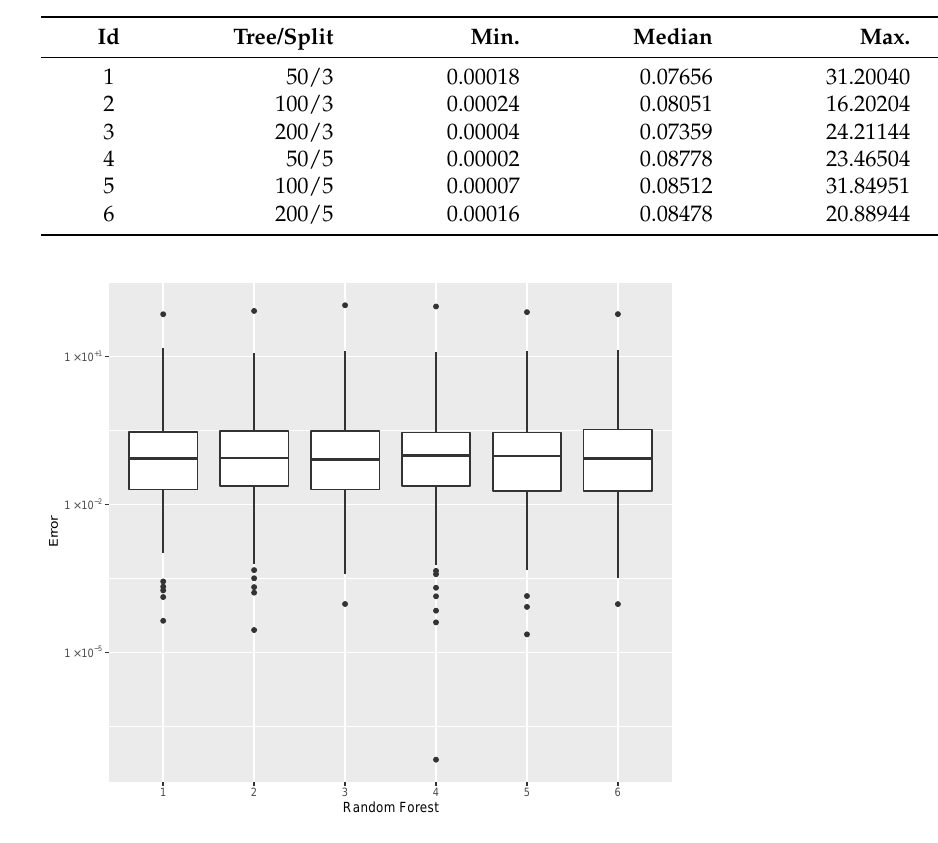
Figure 12. Error dispersion of the mass estimate using distinct Random Forest parameters.